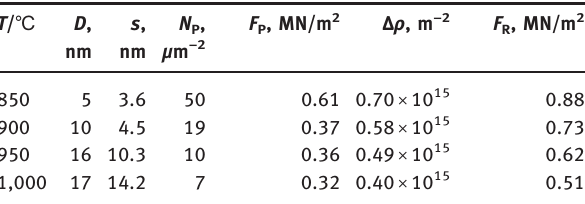
Table 3: Pinning forces of V(C, N) precipitates and driving force of DRX of samples deformed under temperatures from 850°C to 1,000°C.